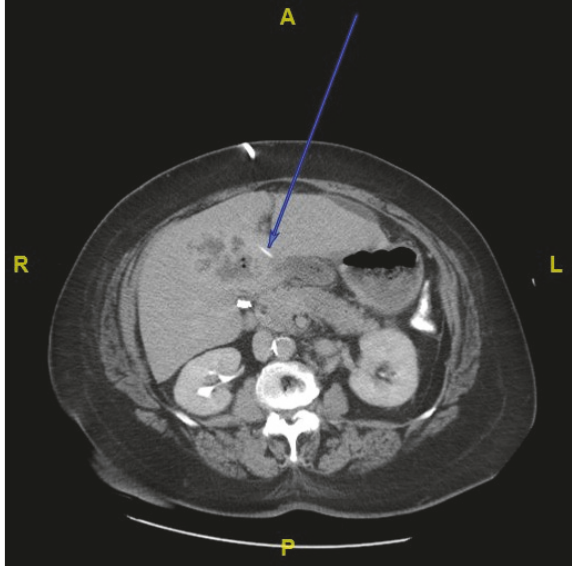
Figure 2: Transverse view indicating foreign body at the level of falciform fissure.